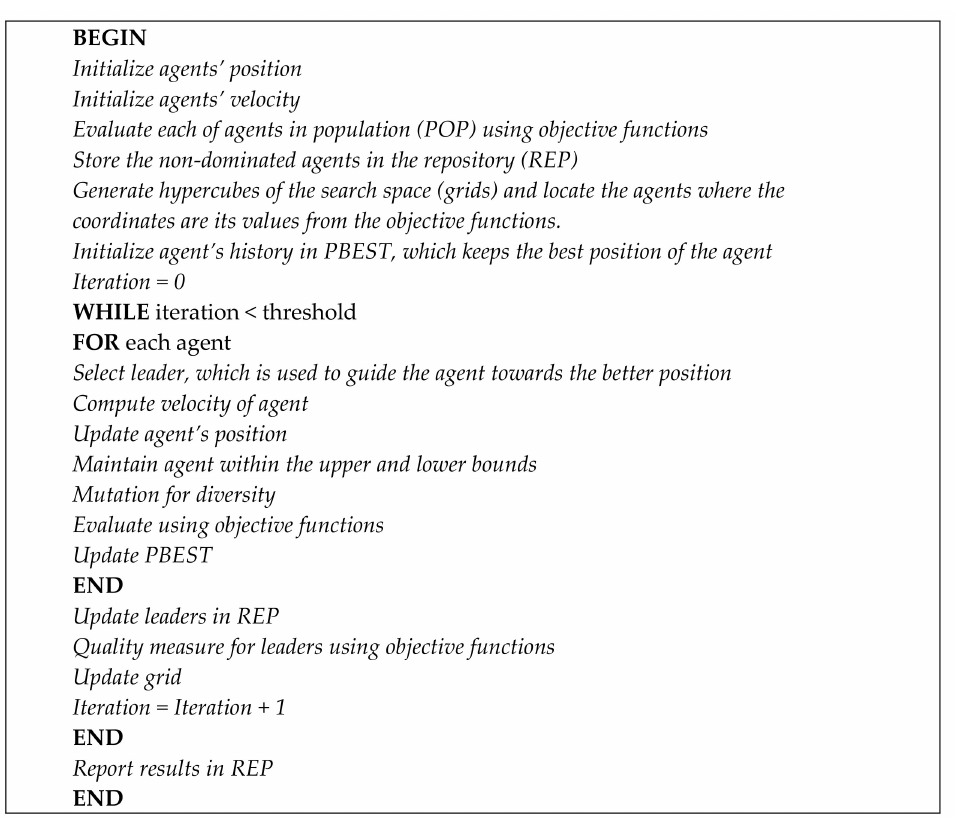
Figure 4. Pseudo-code for